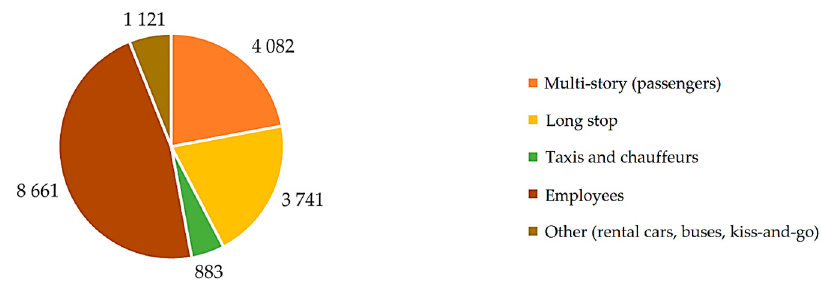
Figure 11. Allocation of car park spaces.